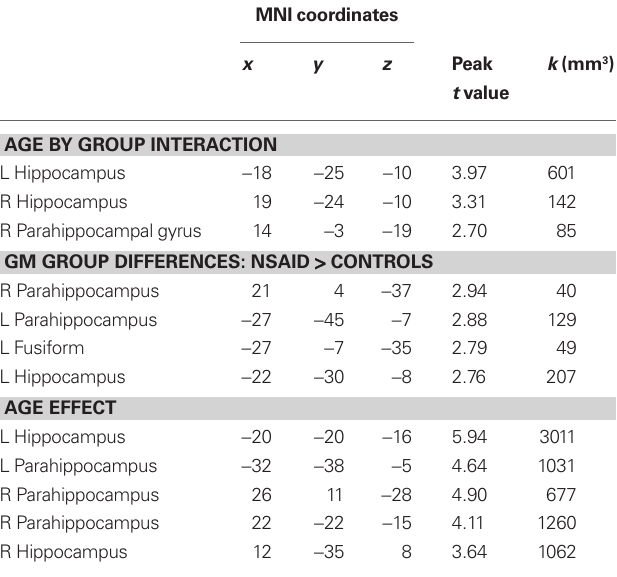
Table 2 | MNI coordinates, t -values, and cluster sizes.